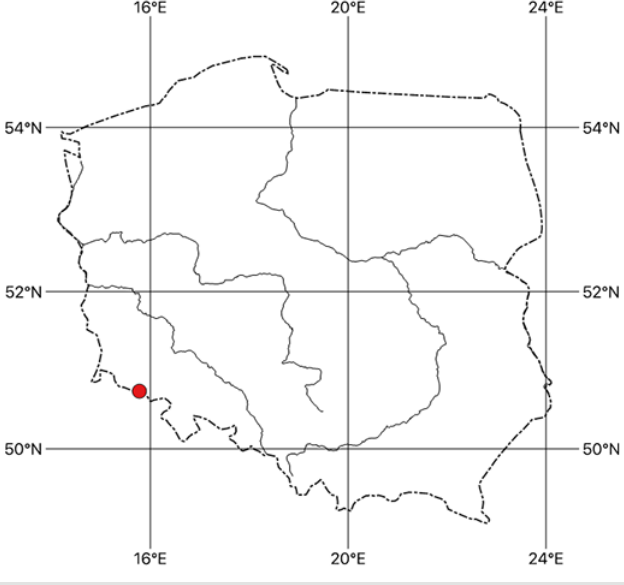
Fig. 1 Location of the Exobasidium rhododendri site in